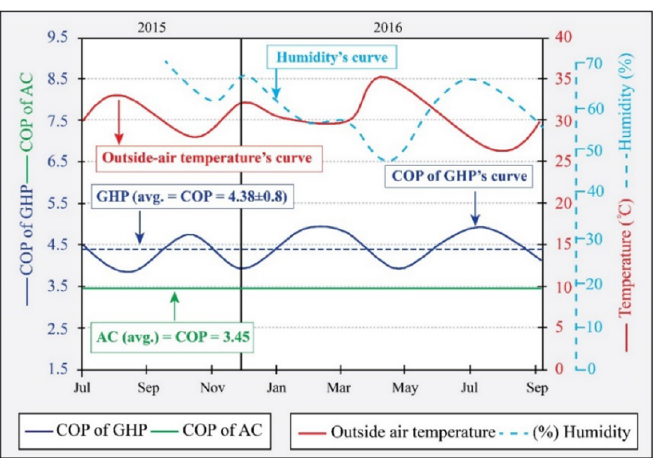
Figure 7. Comparison of the CoP values between the GSHP and conventional AC after one year of operation at 25 °C (July 2015 to September 2016) (obtained from the report by Chokchai et al. [27]).